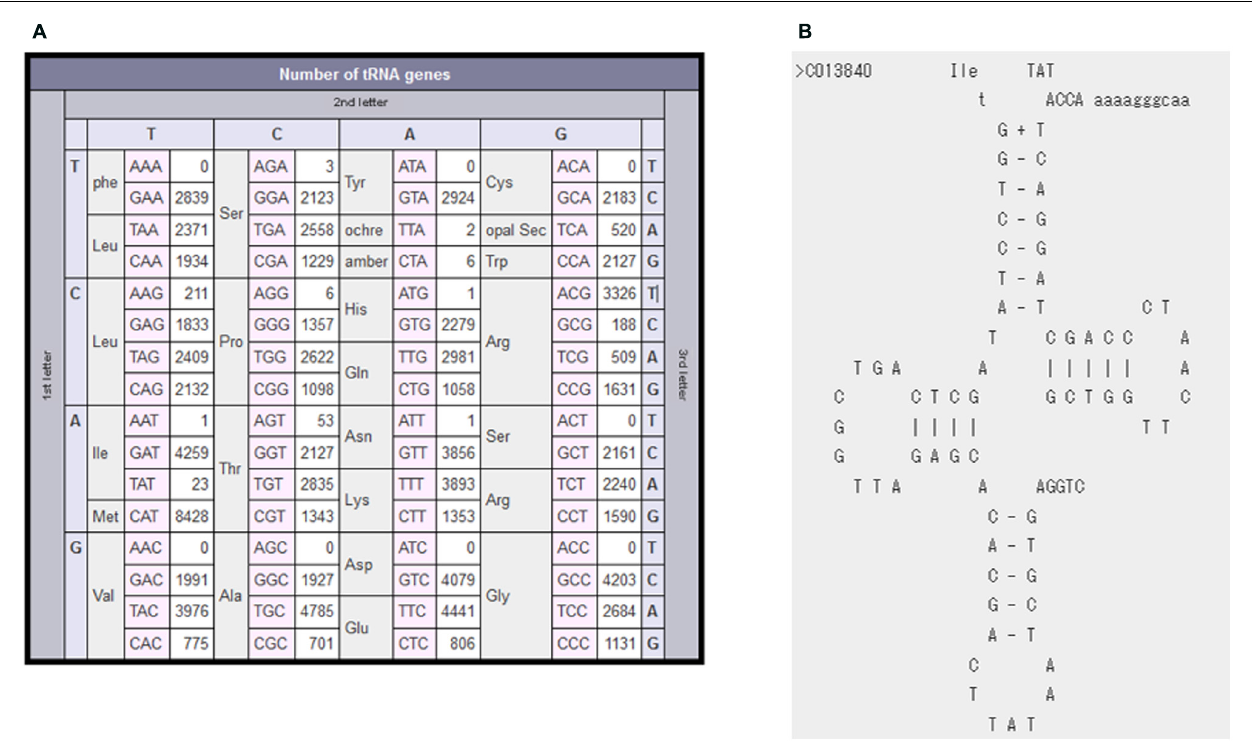
FIGURE 3 | Examples of non-standard-type tRNAs. (A) The anticodon occurrence table of bacterial tRNAs. It is clear that A-starting anticodons are very rare in bacterial tRNAs. (B) Cloverleaf secondary structure of M. mobile tRNA Ile2